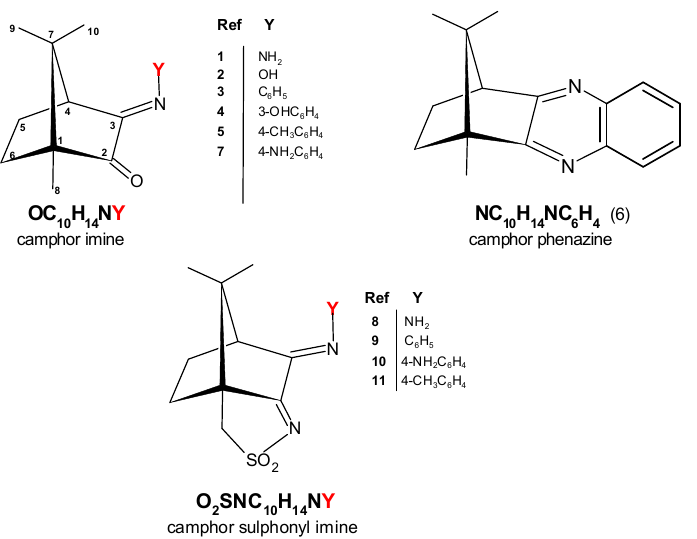
Figure 1. Ligands used in this work: camphor imine ( 1 − 5 and 7 , showing numbering scheme), camphor phenazine ( 6 ), and camphor sulfonimine ( 8 − 11